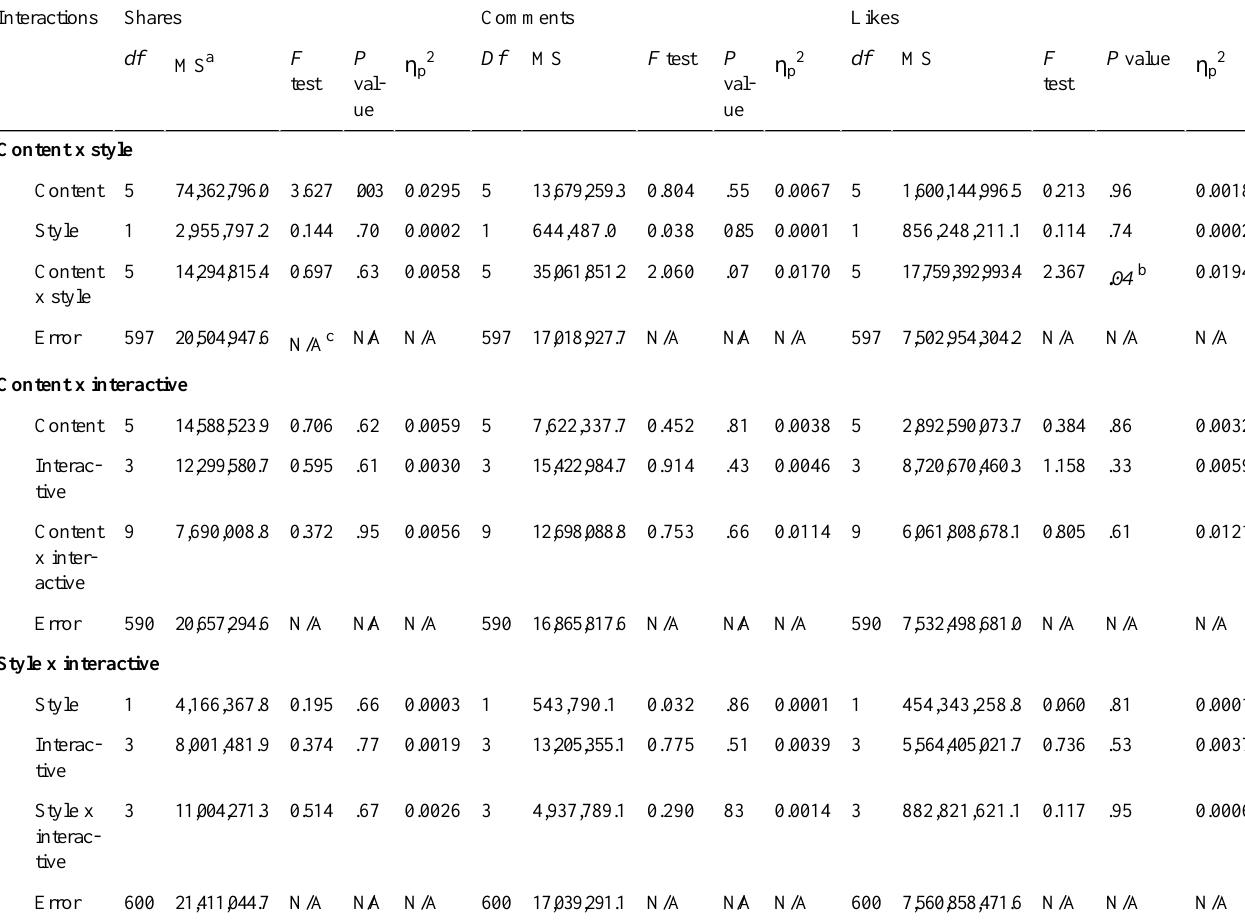
Table 2. Test of interaction effect between content, style, and the interactive